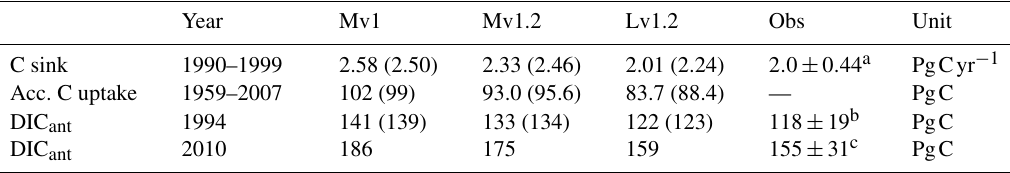
Figure 19. Surface partial pressure of CO 2 (µatm) averaged over the years 1995 to 2005 for model configurations (a) Mv1, (b) Mv1.2, (c) Lv1.2, and (d) the observation-based surface p CO 2 data set of Landschützer et al. (2015a). Panel (e) displays the zonal mean of each field presented in panels (a–d) and additionally the zonal mean of the data product by Takahashi et al. (2009). The black line indicates the mean atmospheric p CO 2 over the averaging period. Table 5. Estimates of the ocean carbon sink, accumulated carbon uptake, and anthropogenic DIC simulated by the three model ver- sions/configurations. Numbers in parentheses are results from the model forced with the CORE-IAF forcing. The second to last column gives corresponding observation-based